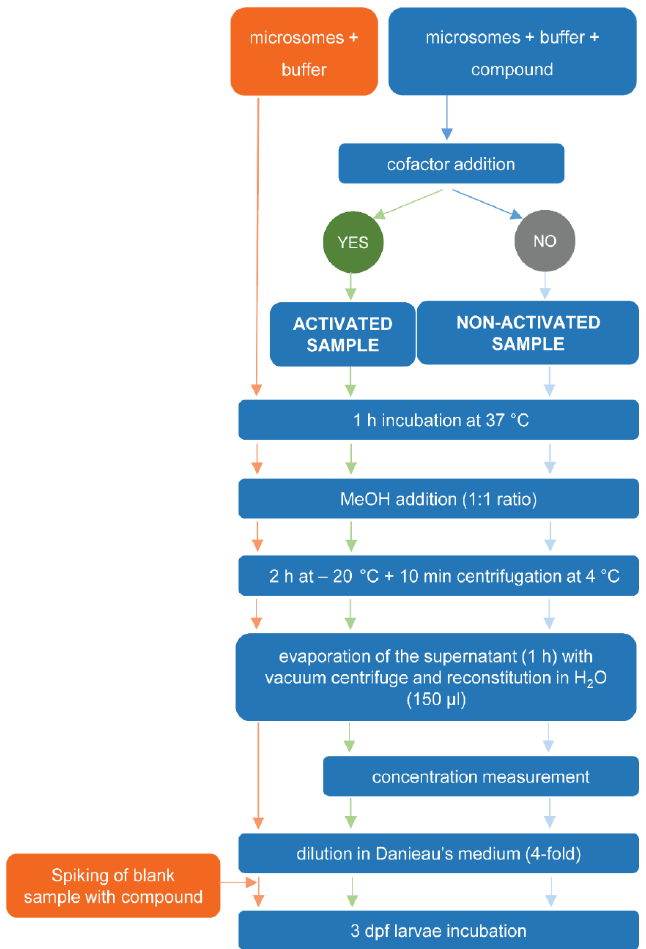
Figure 3. Workflow for the determination of sub-lethal toxicity and lethality of test compounds exposed or unexposed to RLM in zebrafish eleuthero embryos.